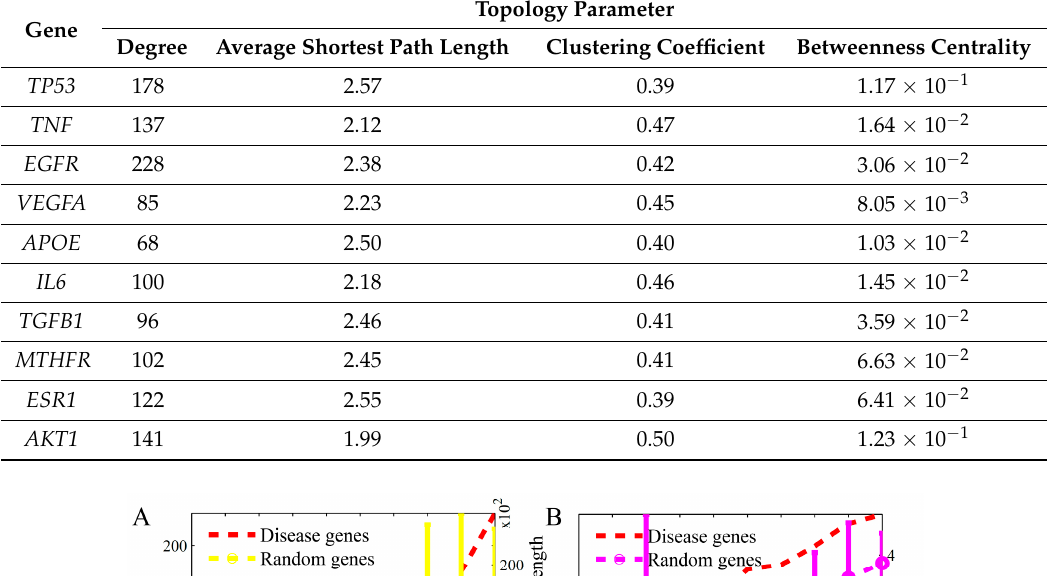
Table 2. The values of network topology parameters in the top-ten popular genes.